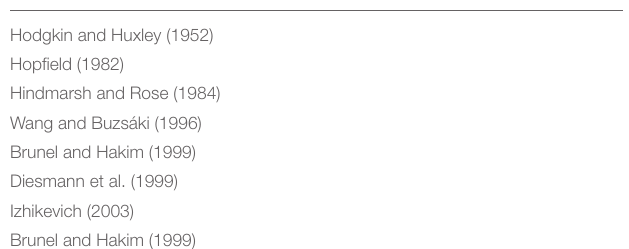
TABLE 1 | Pre-implemented neuronal mechanisms and network models. Neuronal/synaptic mechanisms Spike-timing-dependent plasticity (STDP) (Lazar et al., 2009) Synaptic weight normalization (Lazar et al., 2009) Intrinsic plasticity (IP) (modified from Lazar et al.,